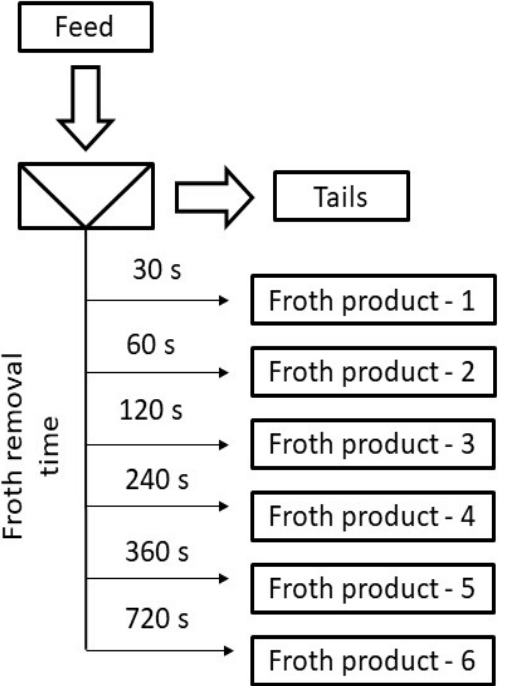
Figure 2. The algorithm of the experimental series.